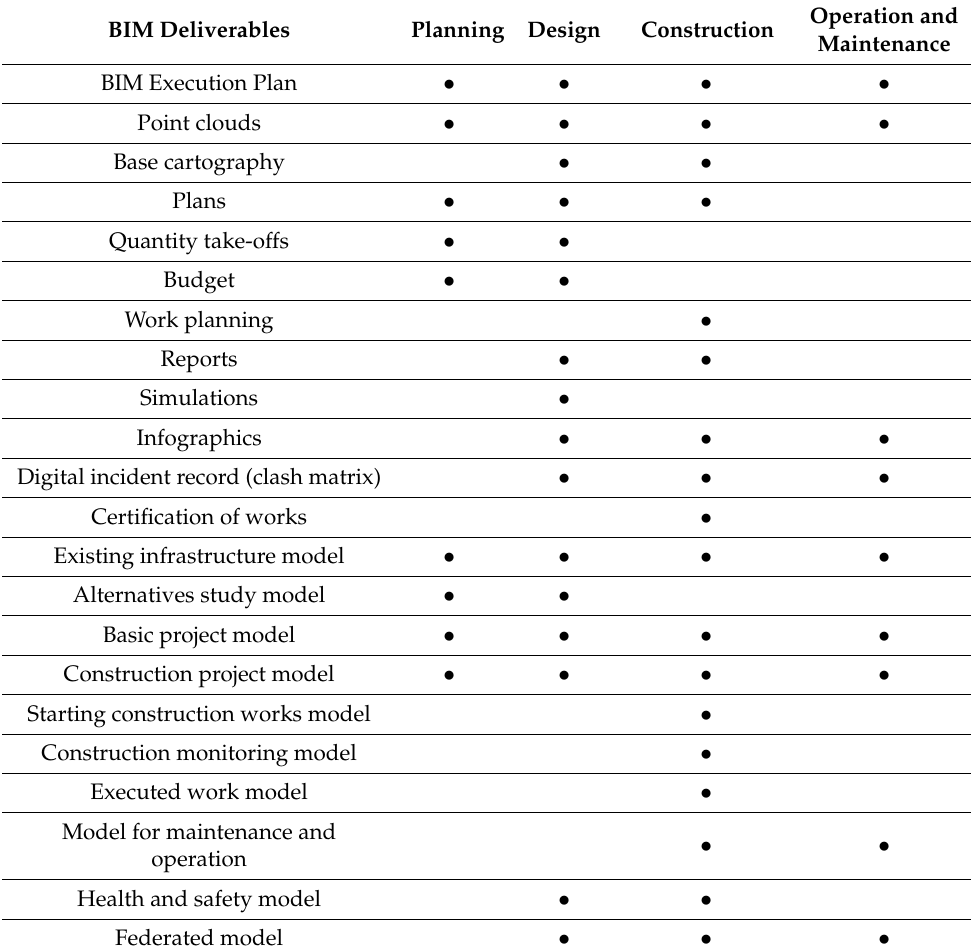
Table 2. Proposed BIM deliverables for inclusion in public sector